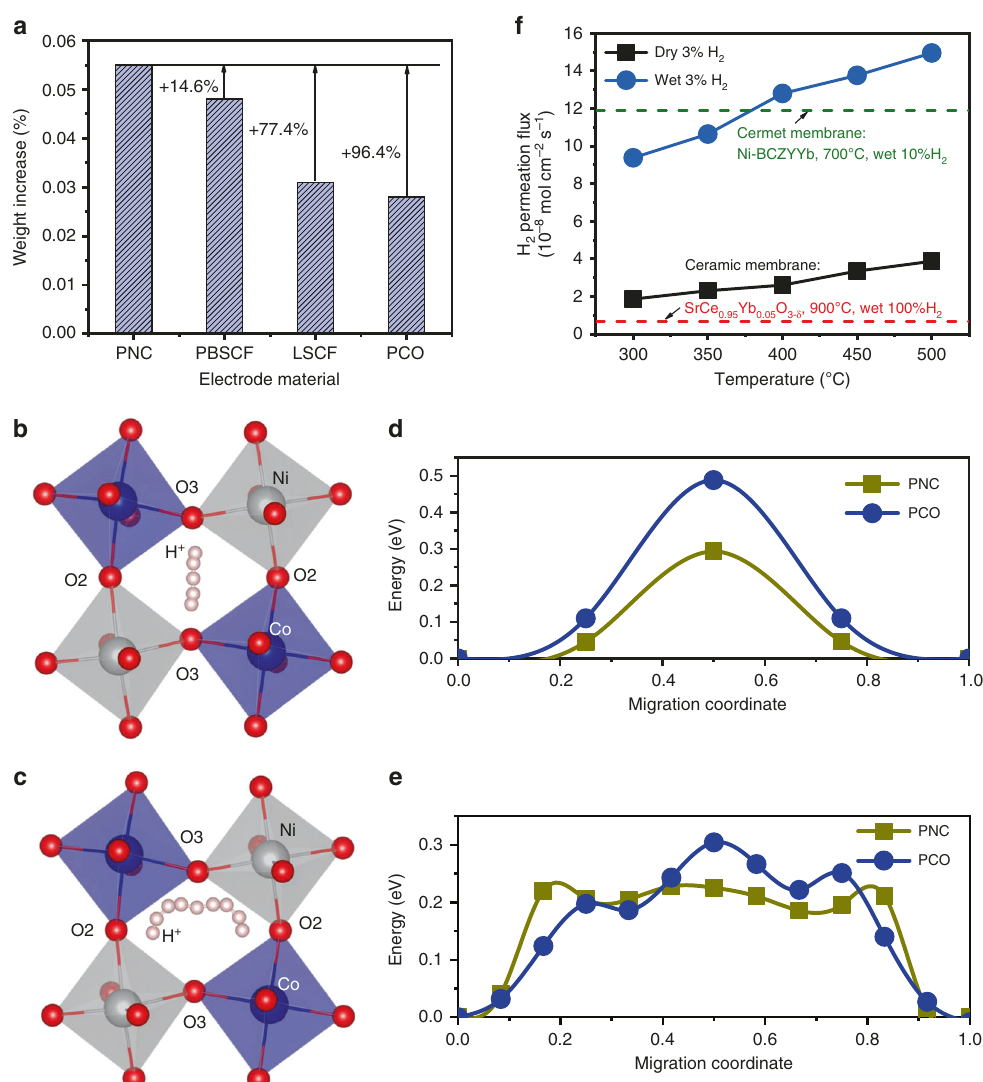
Fig. 2 Study of hydration behavior, hydrogen permeation and proton migration energy. a Comparison of hydration ability for PCO, PNC, LSCF, and PBSCF electrodes at 500 °C in wet air condition. b , c Proton migration pathway I along inter-octahedron direction and pathway II along intra-octahedron direction. d , e Minimum energy paths for proton migration along pathway I and II. f Hydrogen permeation fl uxes of PNC dense